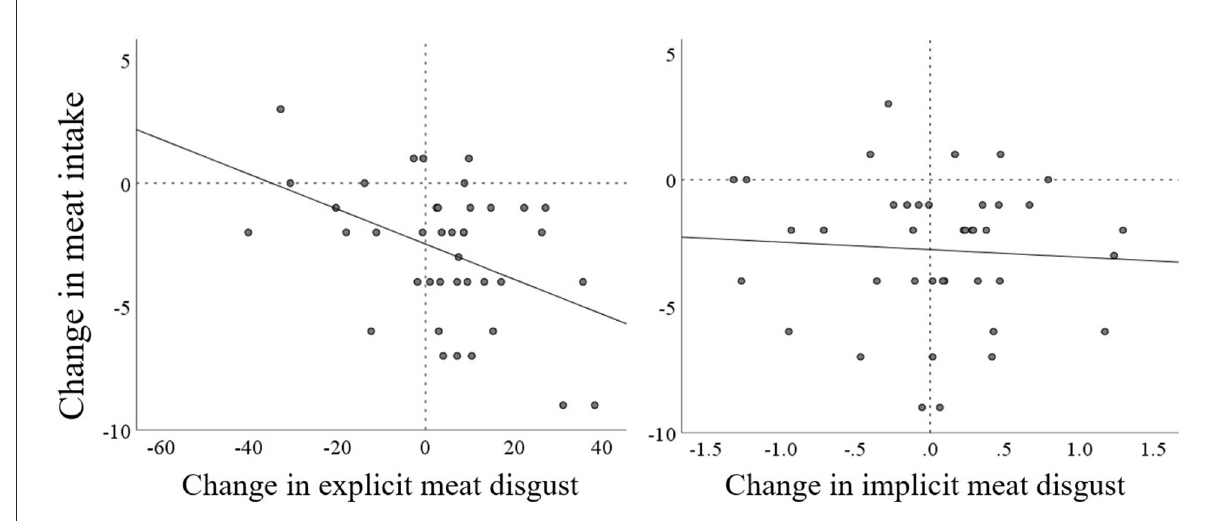
FIGURE2 Scatterplot of changes in meat intake as a function of changes in explicit (left) and implicit (right) meat disgust.